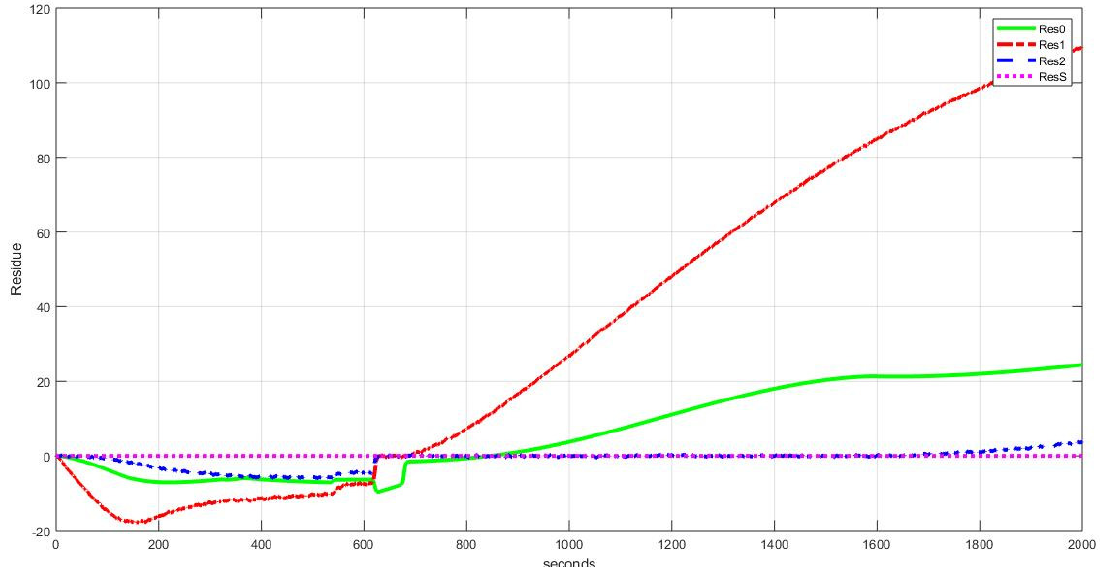
Figure 13. Pond residues for the saturation and leakage fault of sluice gate w 1 .